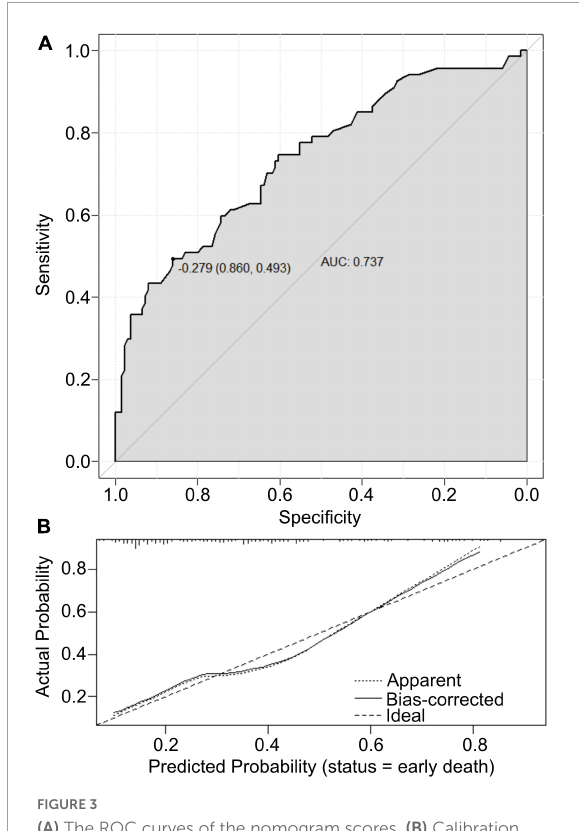
FIGURE3 (A) The ROC curves of the nomogram scores. (B) Calibration plot analyses for nomogram